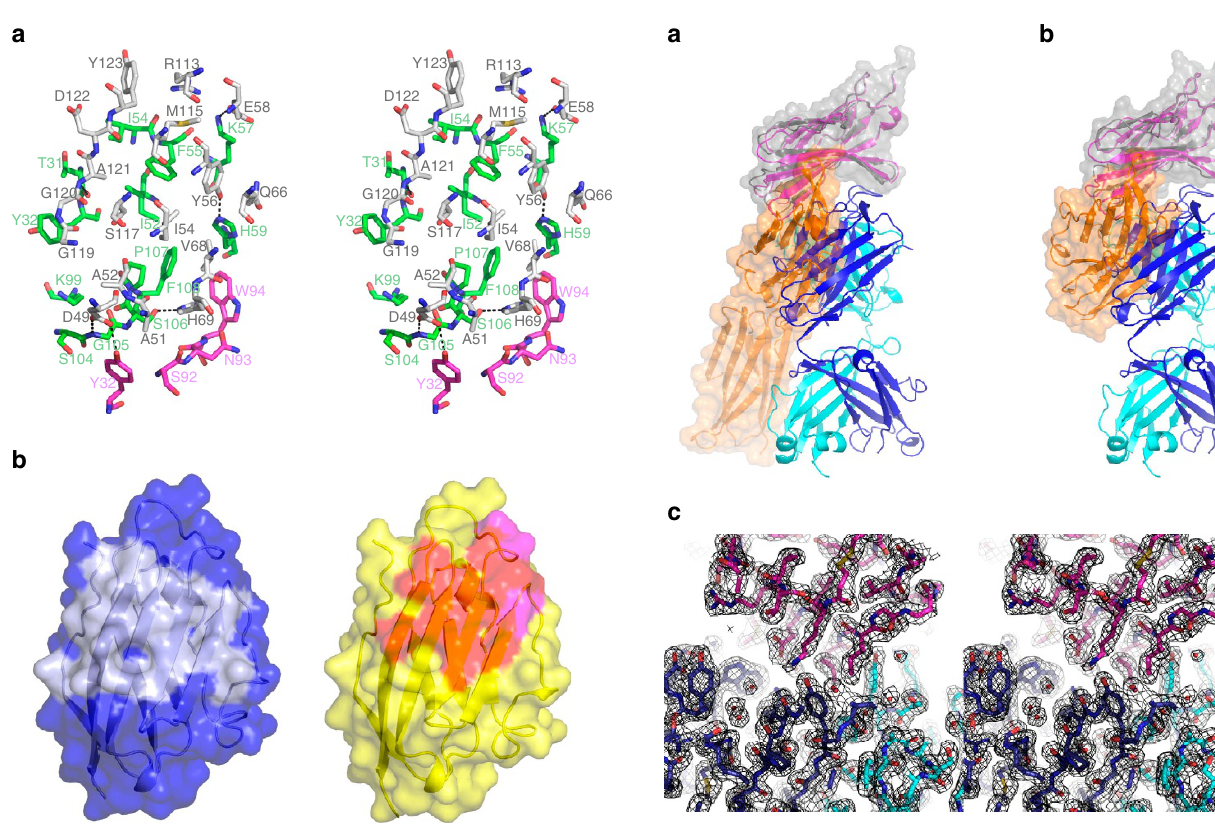
Figure 6 | Crystal structure of CTLA-4 in complex with tremelimumab. ( a , b ) Ribbon representation of CTLA-4 (purple) in complex with tremelimumab Fab fragment (heavy chain: blue, light chain: cyan). In a , the CTLA-4(grey)/B7-1(orange) complex (PDB code 1i8l) was superimposed onto the CTLA-4 molecule in the CTLA-4/tremelimumab complex with a mixed ribbon/surface representation. In b , the CTLA-4(grey)/B7-2(orange) complex (PDB code 1i85) was superimposed onto CTLA-4 in the CTLA-4/ tremelimumab complex with a mixed ribbon/surface representation. ( c ) Stereoview of the 2fo-fc composite omit map (1.2 s contour level) at the interface between CTLA-4 (purple) and tremelimumab (heavy chain: blue, light chain: cyan) calculated at 2.0Å